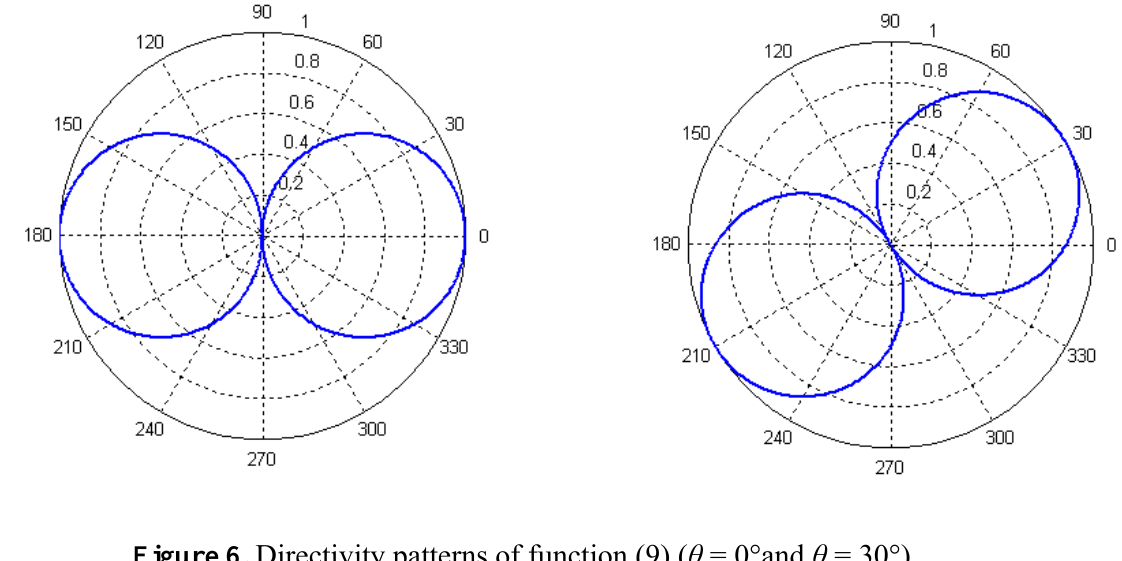
Figure 6. Directivity patterns of function (9) ( θ = 0°and θ =